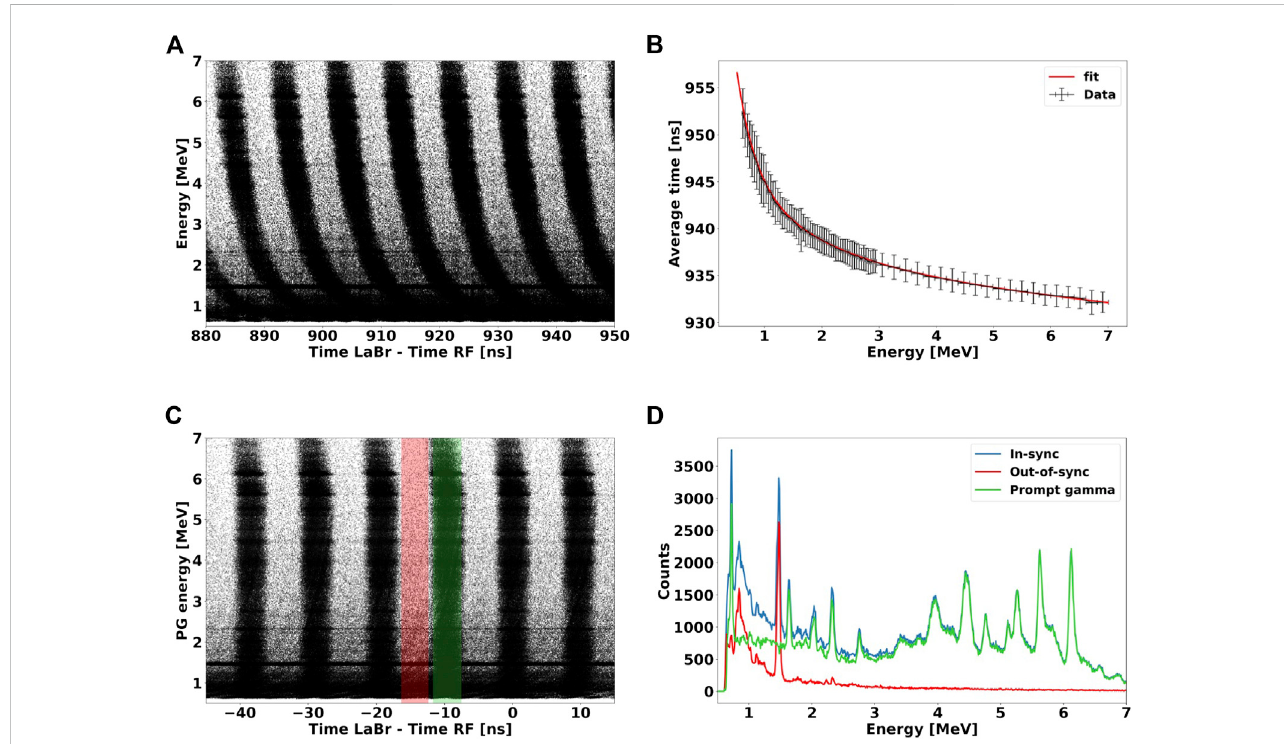
FIGURE 3 (A) : 2D plot of energy deposited versus T LaBr − RF of all acquired events. (B) : average events T LaBr − RF as a function of energy deposited for a single bunch. The solid red line represents the fi t function used to model the time dependence on the gamma energy deposited, caused by the discriminator time walk effect. (C) : 2D spectrum of (A) after the time walk correction has been applied to all events. The color bands mark the time windows used to gate in-sync (green)andout-of-sync(red)events. (D) :energydepositedspectraofallevents(bluelines)acquiredbytheLaBr3:Ceandofeventsout-of-sync(redline) with theRF,whichrepresent theradiation background.The energy spectrum ofprompt gammas (blueline)isobtained bysubtracting theout-of-syncevents from the full spectrum. The spectrum was acquired for 70 MeV protons interacting